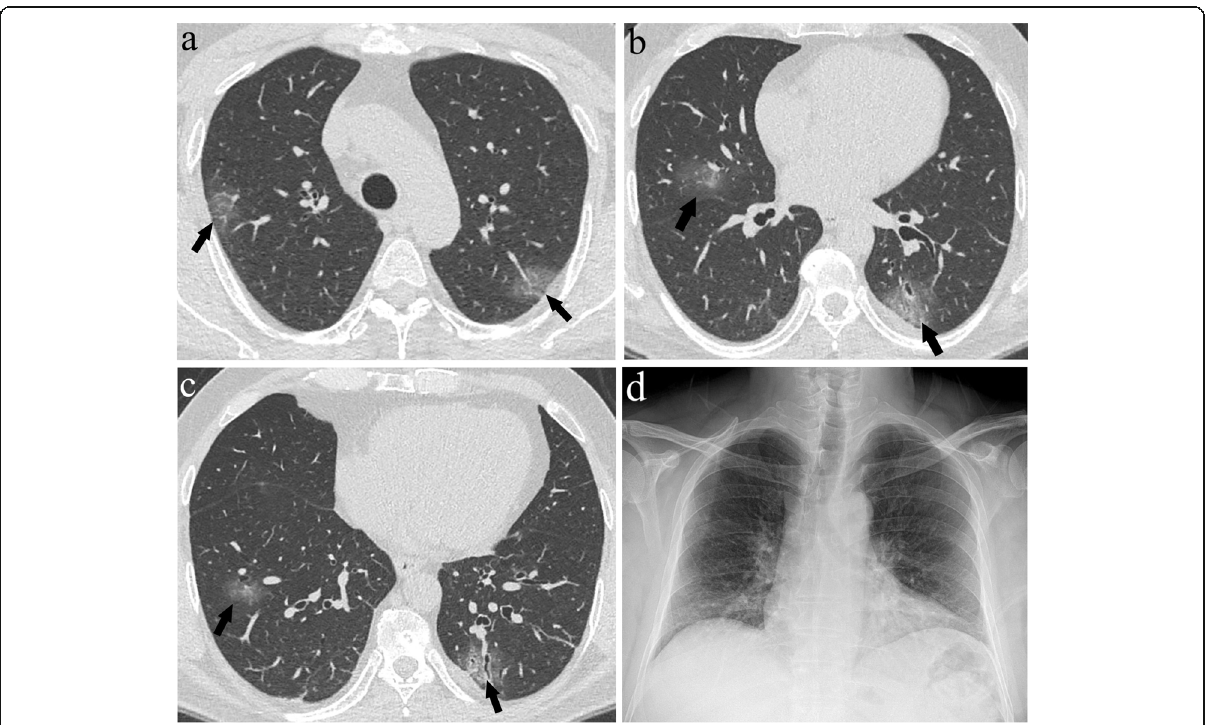
Fig. 5 a – d A 56-year-old male presenting with dry cough and fever for 3 days. Axial CT images at the level of the upper ( a ), middle ( b ), and lower ( c ) lung zones demonstrate ground glass opacities representing grade 1 lesions (arrows) (CTS = 6). There were no signs of pneumonia on the CXR image ( d